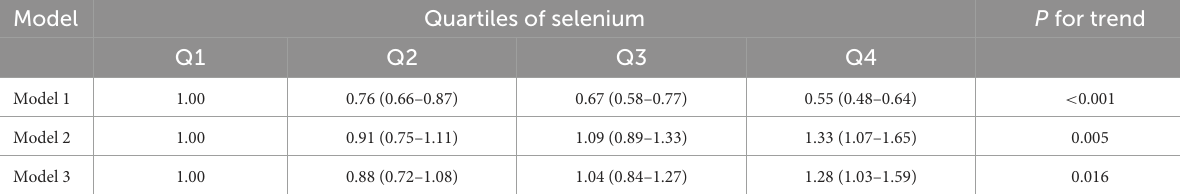
TABLE 4 Association between dietary selenium and osteoarthritis using logistic regression.